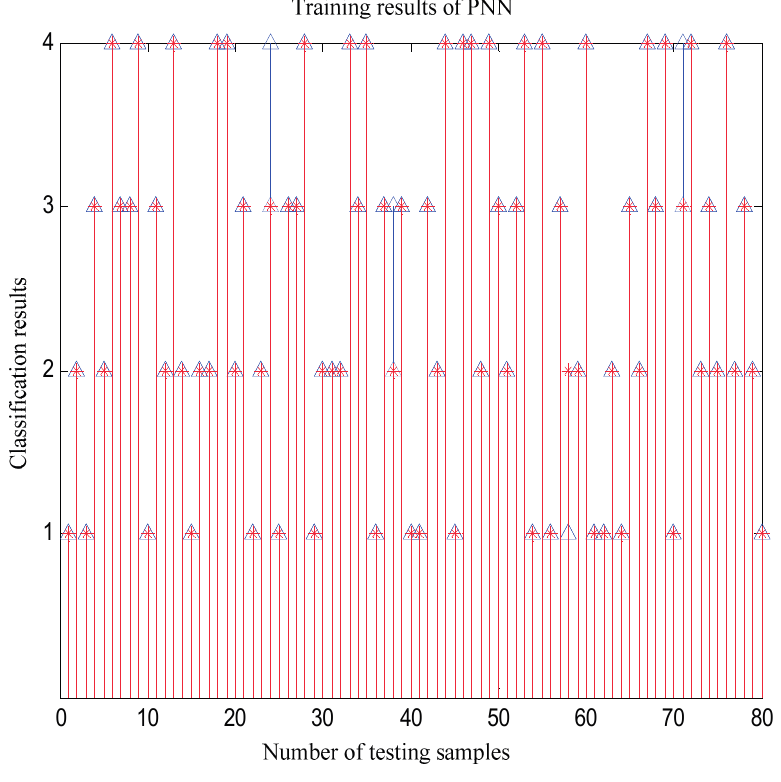
Figure 12. Classification results of PNN under testing